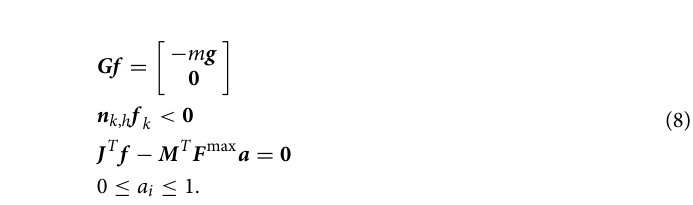
Figure 2. Grasping mechanics. ( A ) Forces applied to the object. ( B ) Friction cone approximated by a polygonal pyramid. The fingertip force vector must be positioned inside the friction cone. ( C ) Modeling of the contact of the distal phalanx. Two contact points 2 mm away from the centroid of the contact area were introduced to account for generation of a torsional moment during precision